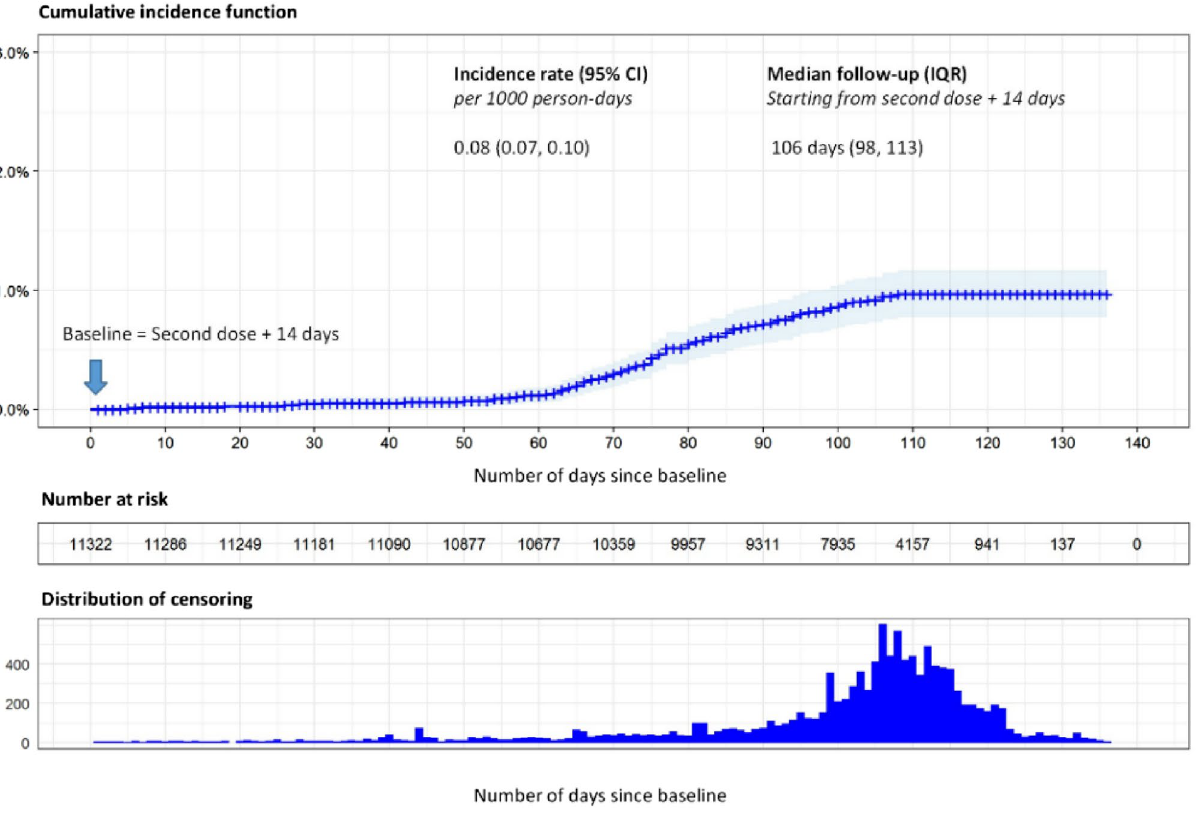
Figure 2. Kaplan–Meier estimates of cumulative incidence rate.